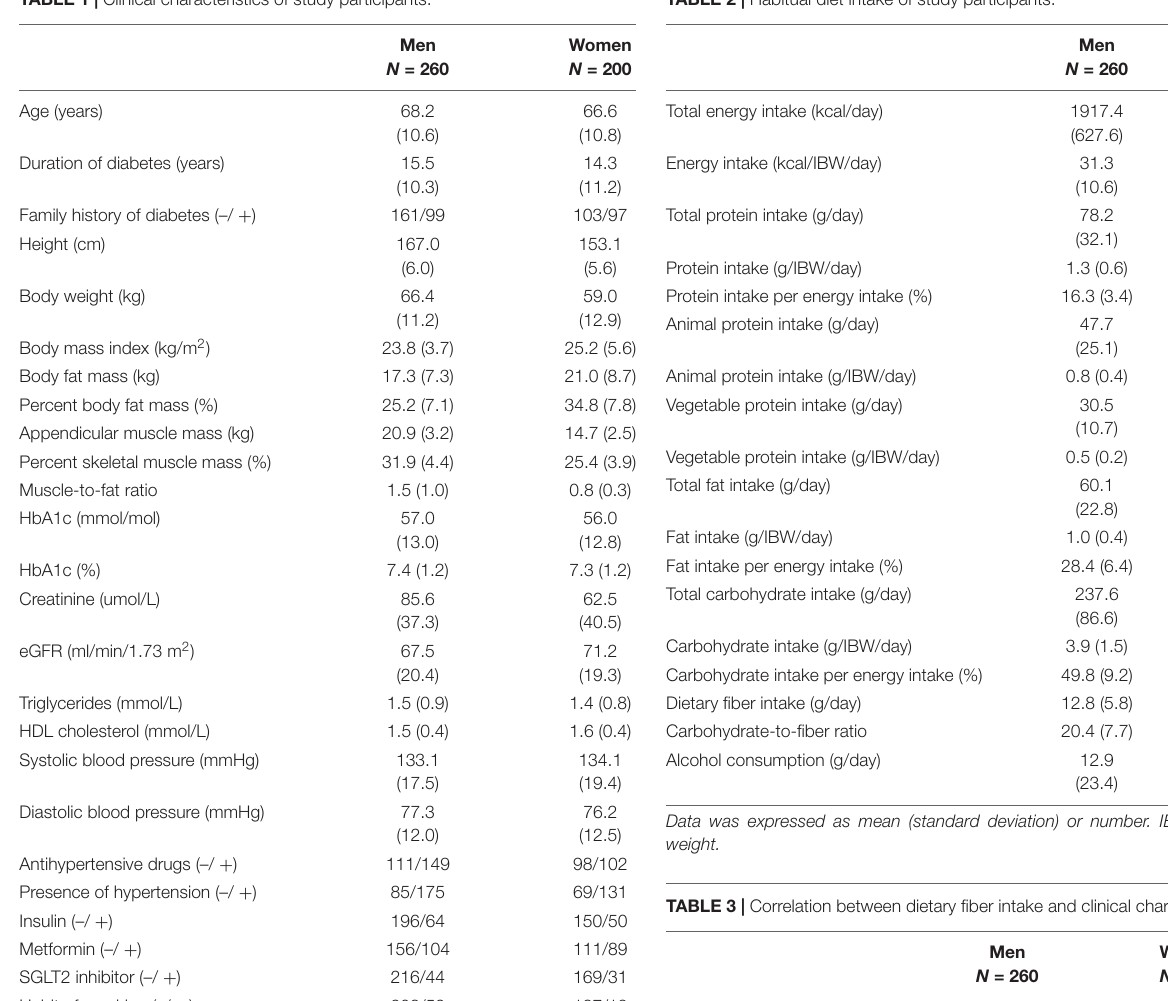
TABLE 1 | Clinical characteristics of study participants. TABLE 2 | Habitual diet intake of study participants.